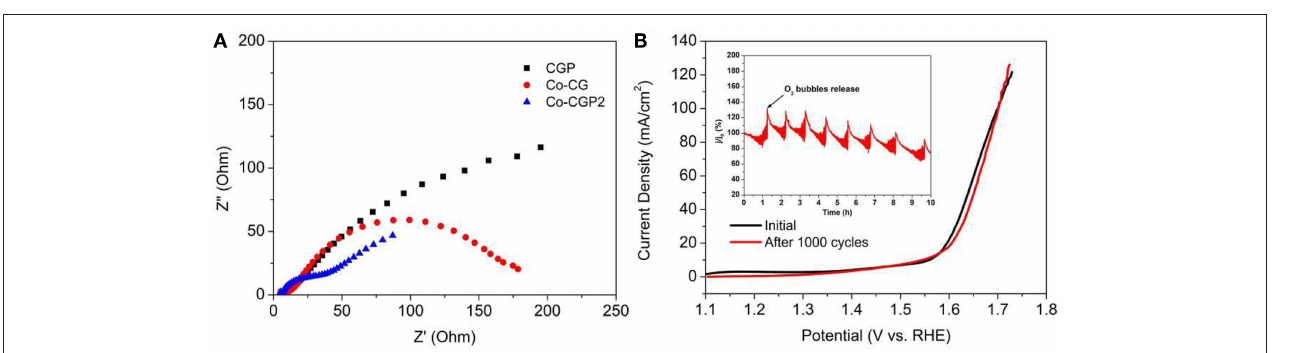
Frontiers in Chemistry |